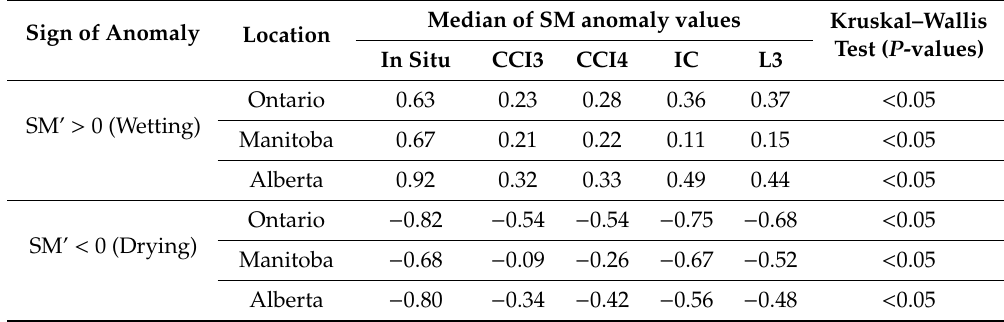
Table 3. Median of positive and negative SM anomaly values for in situ and satellite products at all networks. The summary of the Kruskal–Wallis test is also included and statistical di ff erences are significant for P <